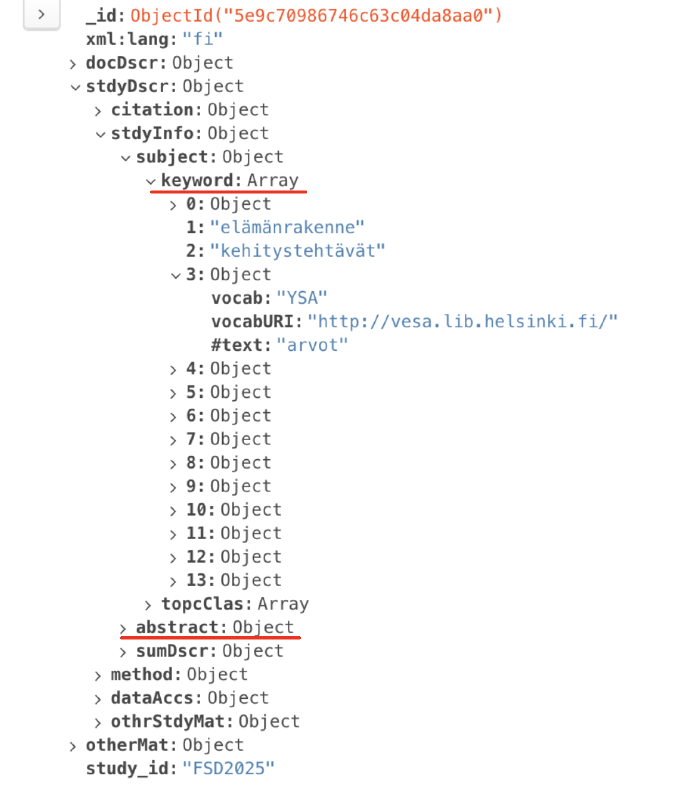
Figure 2. The attributes included in the metadata structure of an example study. The abstract and the keyword attributes are underlined in